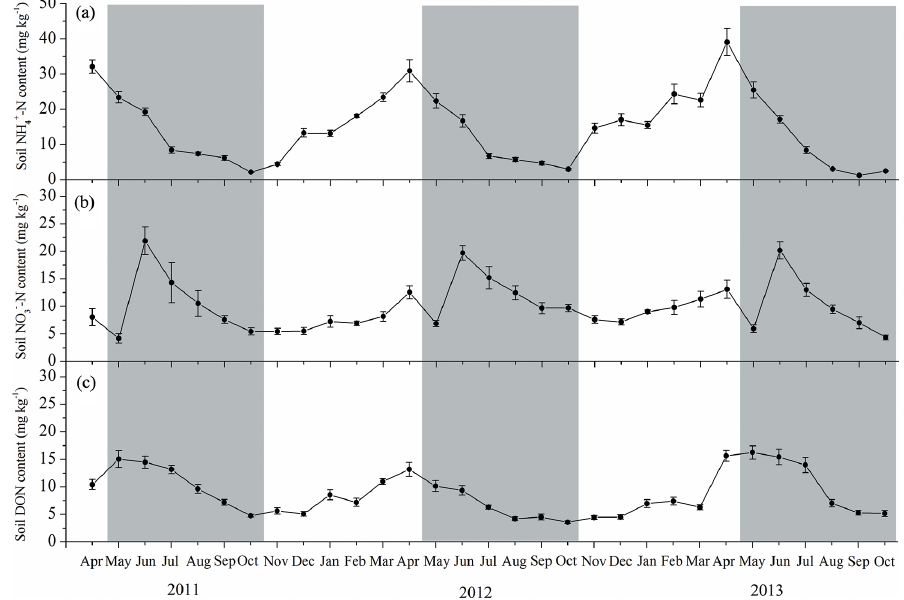
–N (a) , NO − –N (b) , and DON (c) in soils of the alpine meadow from April 2011 to October 2013 (mean ± SE; 4 3